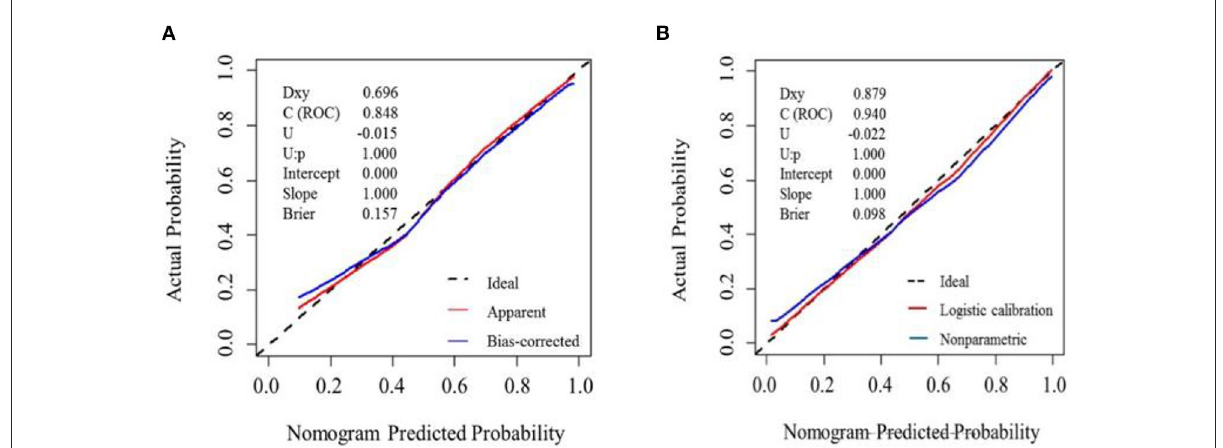
FIGURE3 Calibration plot for nomogram in the (A) development cohort and (B) validation cohort. The x -axis represents the predicted probability and y -axis represents the actual probability. A subset of various statistics useful for validating the model are also shown. Dxy: Somers’ Dxy rank correlation between p (predicted possibilities) and y (actual outcome = 0 or 1). C (ROC): the ROC area. U, Unreliability index. Brier: average squared difference in p and y. (A) Dashed line (“Ideal”) represents ideal predictions. The red line represents the entire cohort ( n = 134), and the